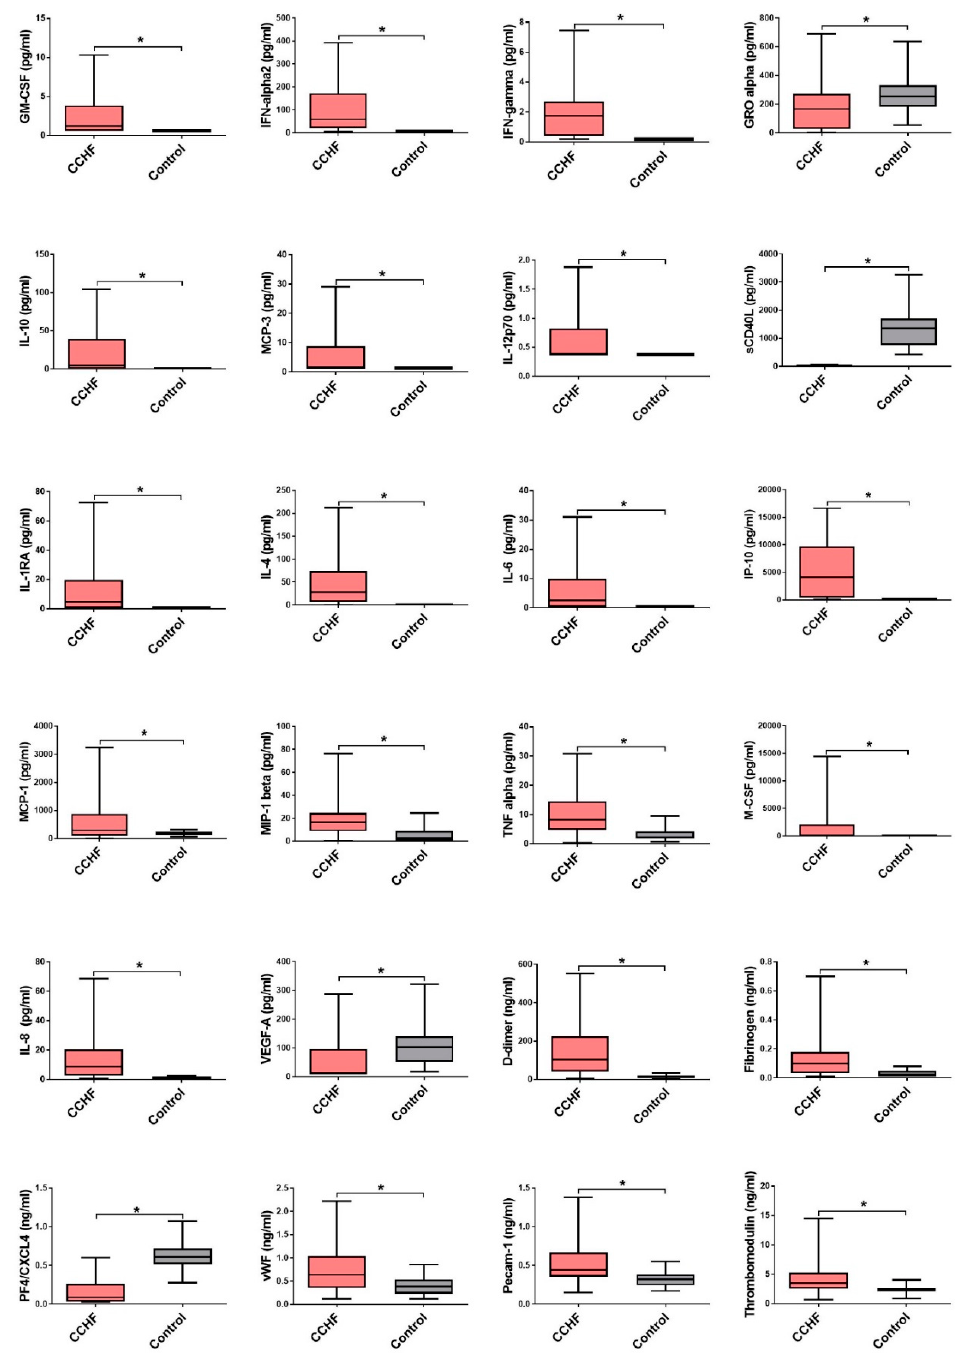
Figure 3. The cytokine and chemokine concentrations with significant differences in CCHF patients ( n = 70) in comparison to control group ( n = 30). The samples were obtained median six days after the onset of symptoms. The statistically significant differences are marked with * ( p < 0.05). ns= not statistically significant. The boxes represents medians with interquartile ranges; the whiskers depict minimum and maximum values (range). Identified outliers are not included in the figures above: GM-CSF (CCHF n = 5), IFN- α (CCHF n = 5), IFN γ (CCHF n = 1), GRO- α (CCHF, n = 6), IL-10 (CCHF n = 5), MCP-3 (CCHF n = 8), IL-4 (CCHF n = 8), IL-6 (CCHF n = 1), MCP-1 (CCHF n = 1), MIP-1 β (CCHF n = 7), M-CSF (CCHF n = 1), VEGF-A (CCHF n = 6), TM (CCHF n = 5).